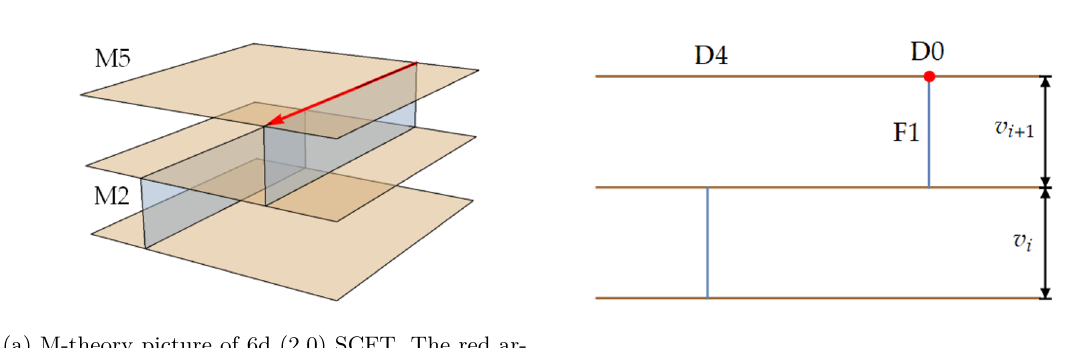
Figure 1. Brane description of 6d SCFT/5d SYM on the tensor/Coulomb